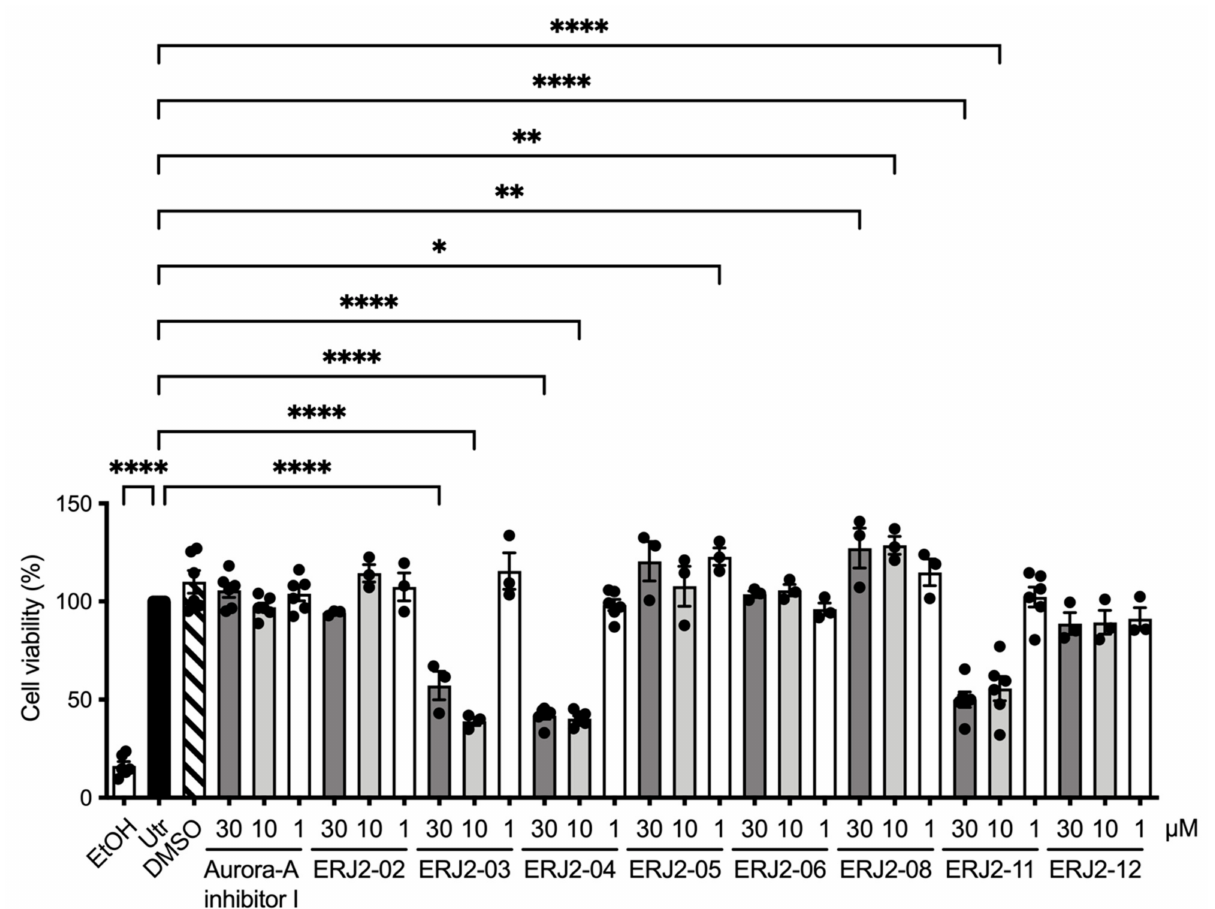
Figure 5. Effects of Aurora-A inhibitor I and its derivatives on the viability of MCD4 cells. Cell proliferation was assessed using the CellTiter 96 ® Aq ueous One Solution Cell Proliferation Assay (Promega; Walldorf, Germany). MCD4 cells were left untreated (Utr) or treated with DMSO (0.3%, 1 h) or compound (30 µ M, 10 µ M or 1 µ M, 1 h). As negative controls, i.e., to induce maximal toxicity, cells were incubated with ethanol (EtOH). Shown are means ± SEM of three or six independent exper- iments. Statistically significant differences compared to untreated cells are indicated, **** p < 0.0001, ** p < 0.01, * p <